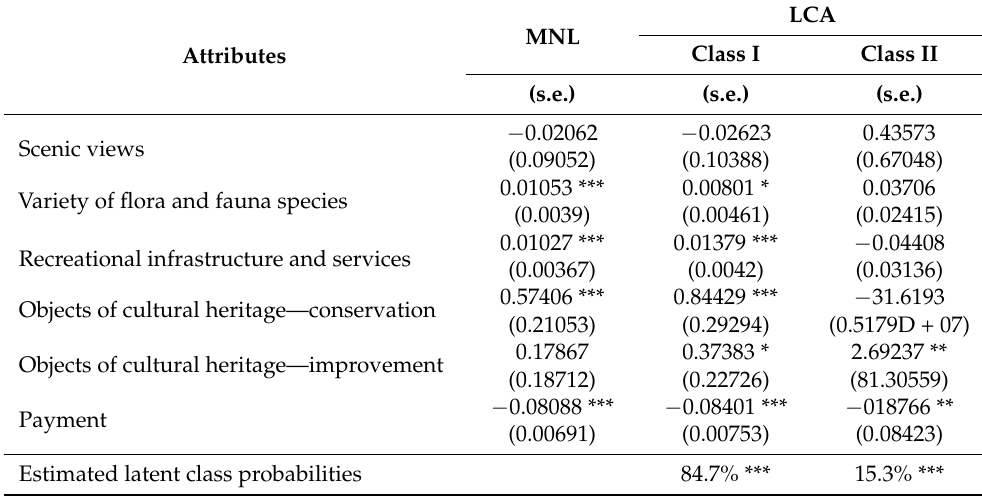
Table 5. MNL and LCA